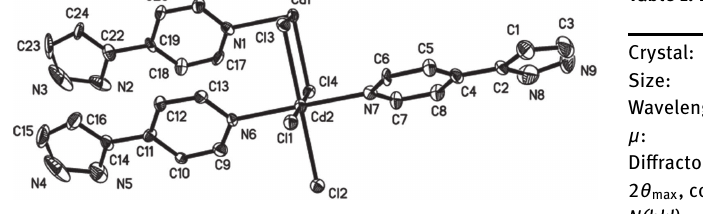
Table 1: Data collection and